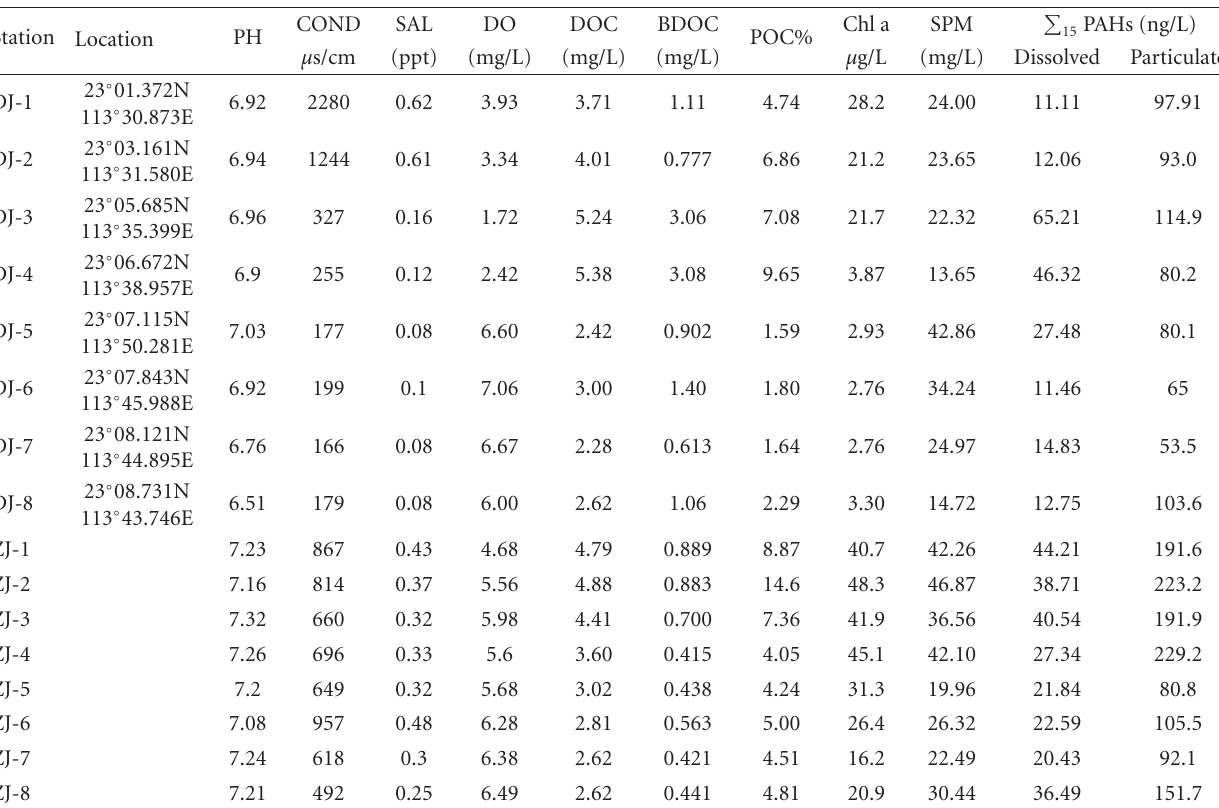
Table 2: Major aquatic chemical properties of the water samples in April 2011. Station